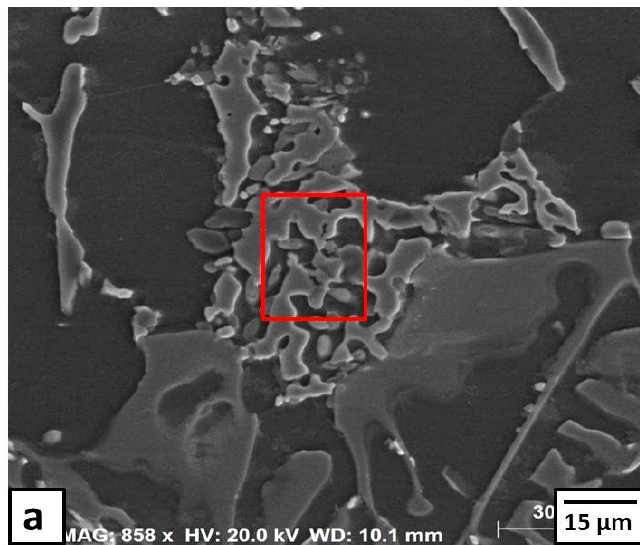
Figure 10. Cont. Figure 10.